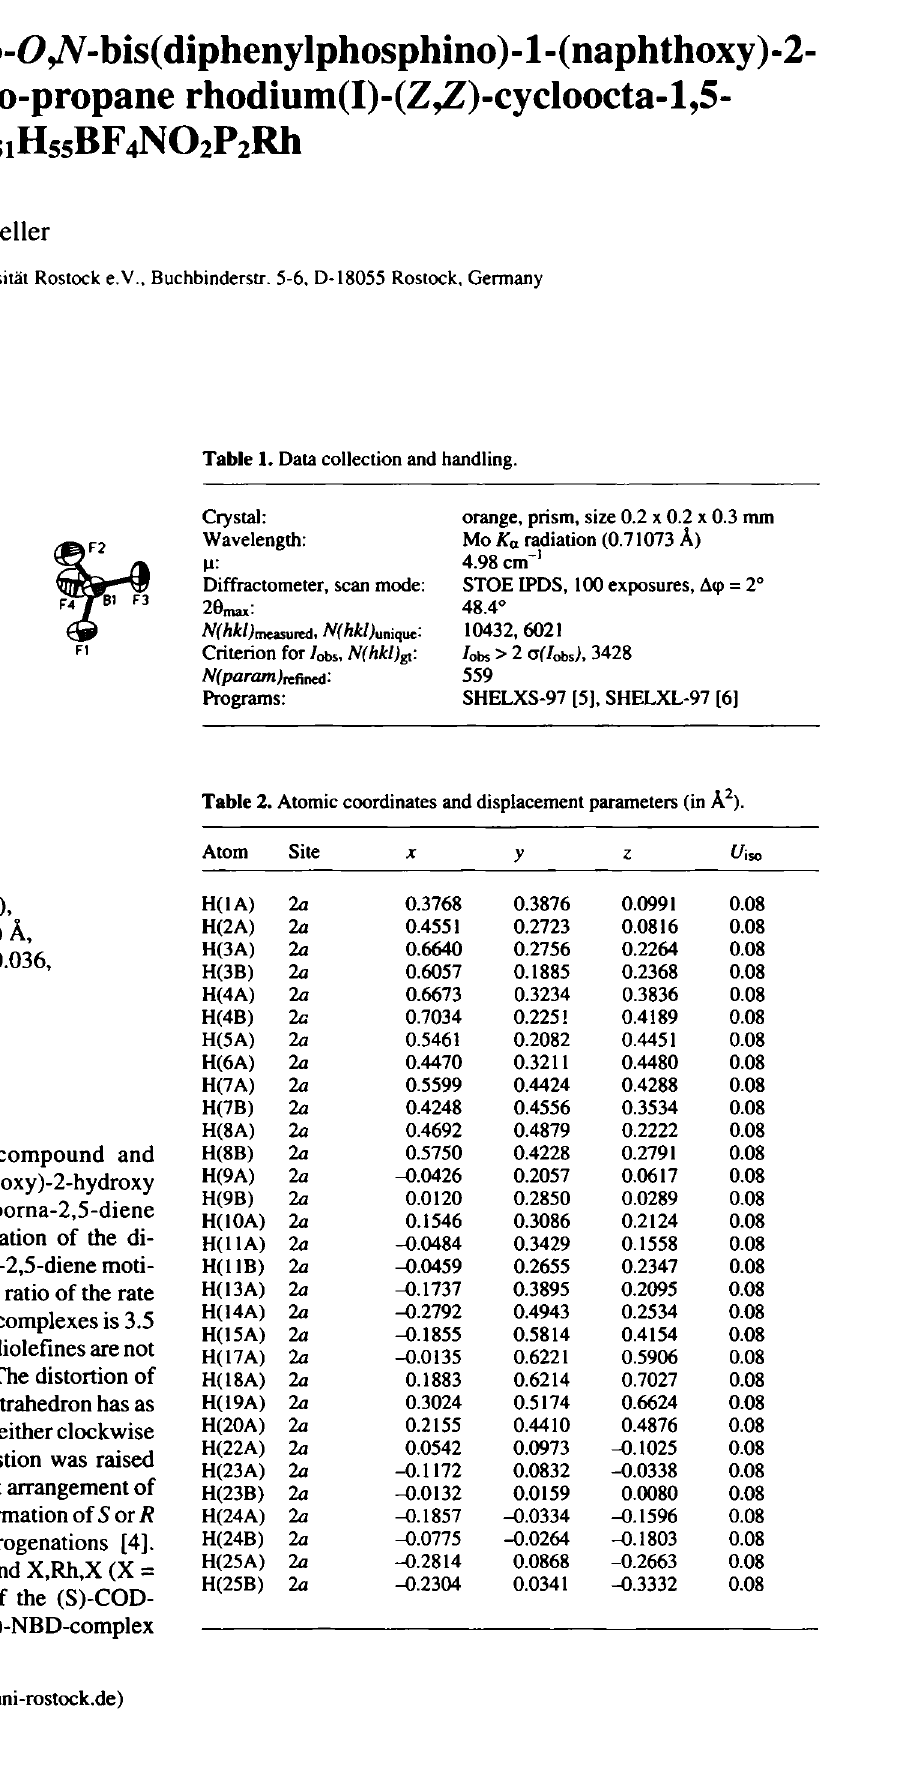
Table 2. Atomic coordinates and displacement parameters (in A 2